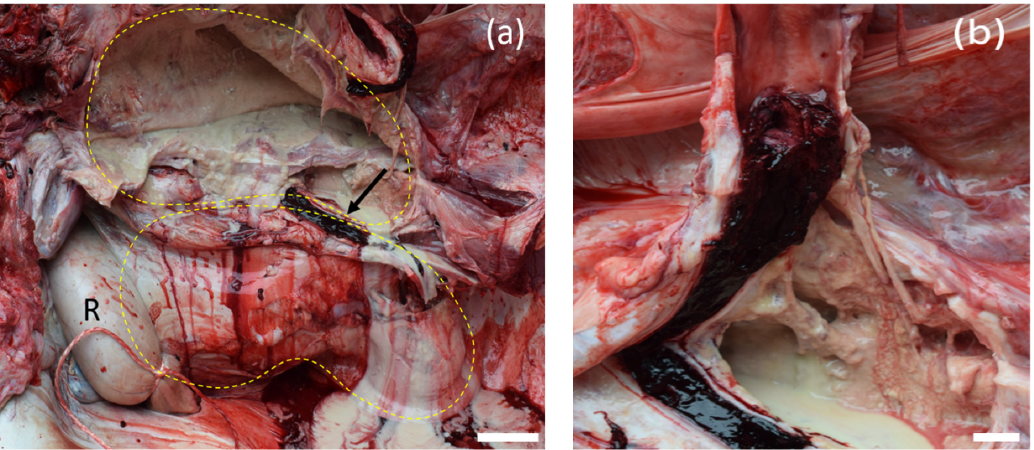
Figure 1. ( a ) Rhinoceros in left lateral position, retroperitoneal abscess. A massive two-chambered abscess filled with over 80 L pus was located ventrally to the spine. The right iliac artery (black arrow) firmly attached to the abscess showed a precipitation thrombus. The degree of abscess formation is illustrated by yellow dotted lines. R = rectum, bar = 10 cm. ( b ) Thrombus of the right iliac artery, opened longitudinally. An arterial thrombus was firmly attached to the inner vessel wall over its total length, bar = 1 cm.